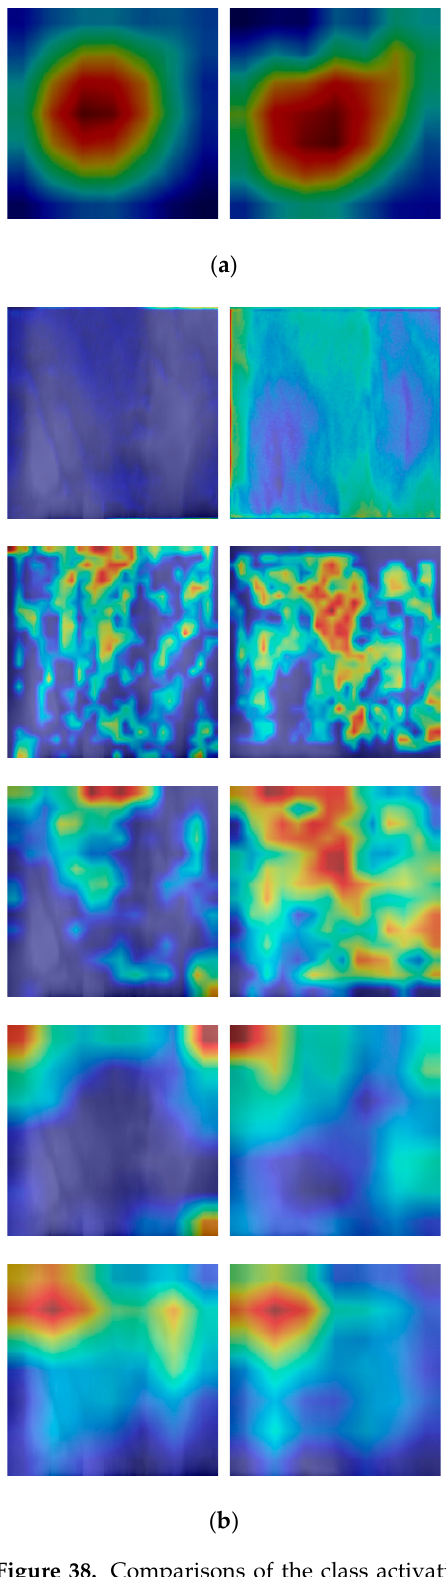
Figure 38. Comparisons of the class activation maps between the original and restored images. ( a , b ) are examples of authentic and imposter images, respectively. The images on the left of ( a , b ) are the original images, and the images on the right are restored images by RMOBF-Net. ( a , b ) show the 1st convolutional layer, 1st transition layer, 2nd transition layer, 3rd transition layer, and the class activation map outputs from the last dense block from top to